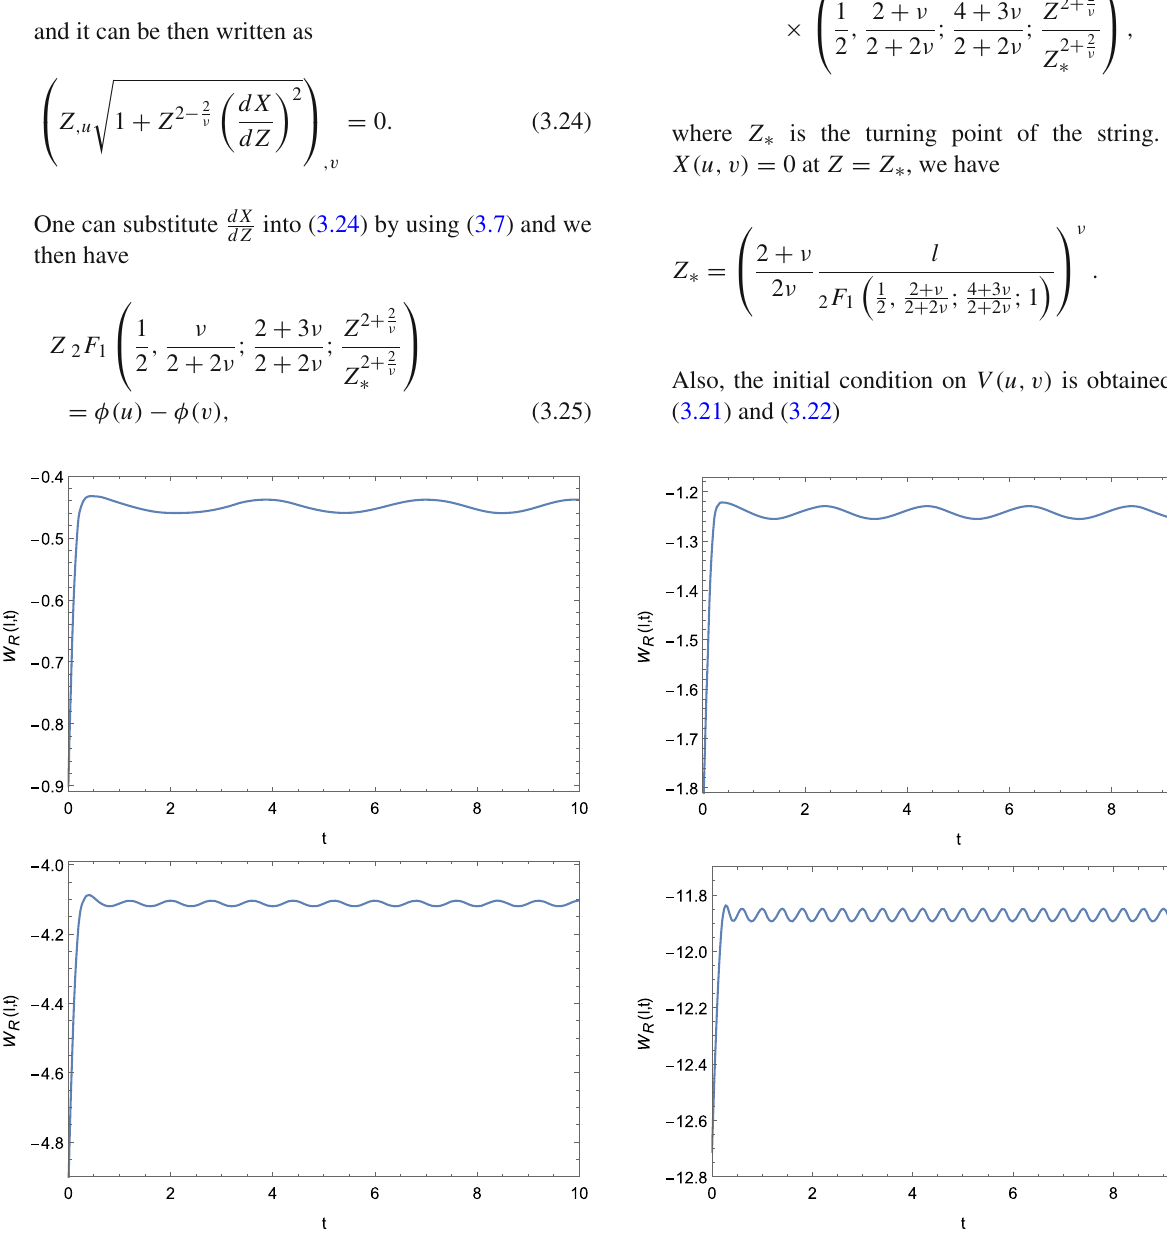
Fig. 2 The expectation value of the Wilson loop in terms of boundary time for ν = 1 (top-left), ν = 2 (top-right), ν = 3 (bottom-left) and ν = 4 (bottom-right). For all figures we set k = 0 . 3, T